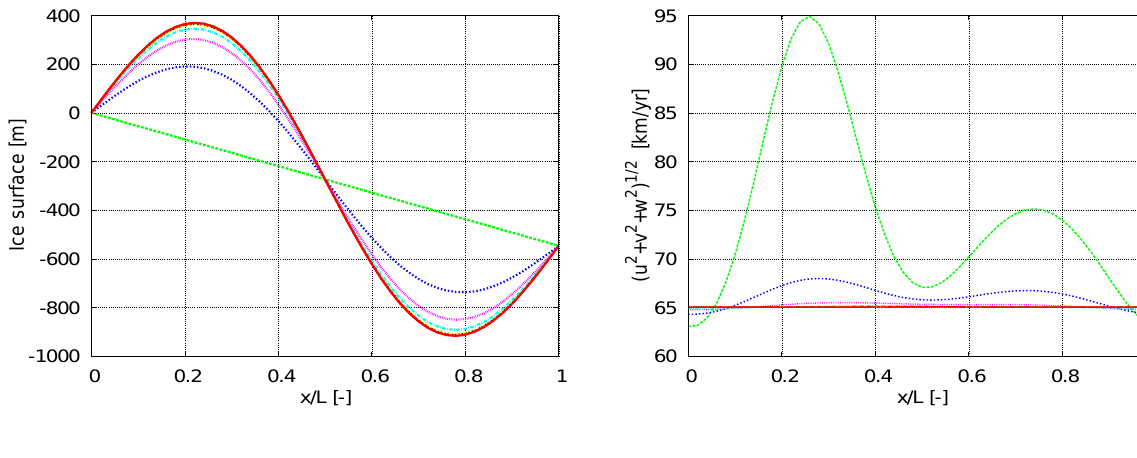
(cid:16) (cid:17) 1 / 2 u 2 + v 2 + w 2 (right)